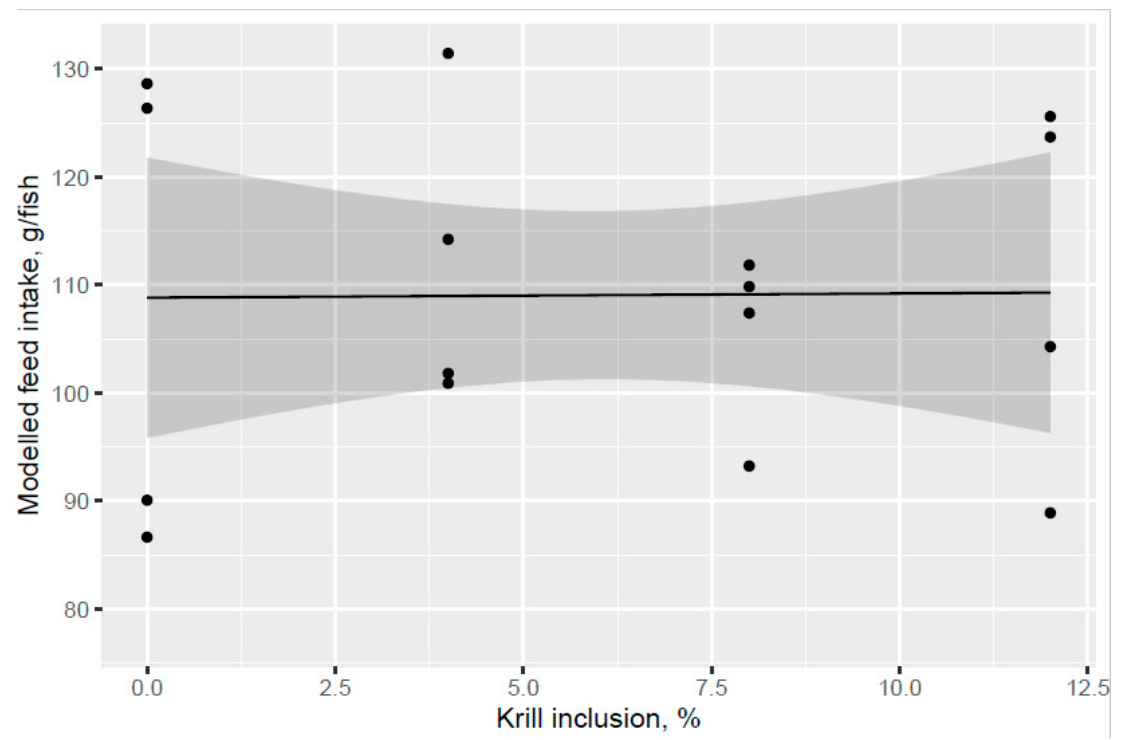
Figure 1. Modelled feed intake in relation to increasing KM inclusion after 53 d of feeding in the freshwater pre-transfer phase. Dots denote observed tank mean feed intake with error bars giving 95% credible intervals.